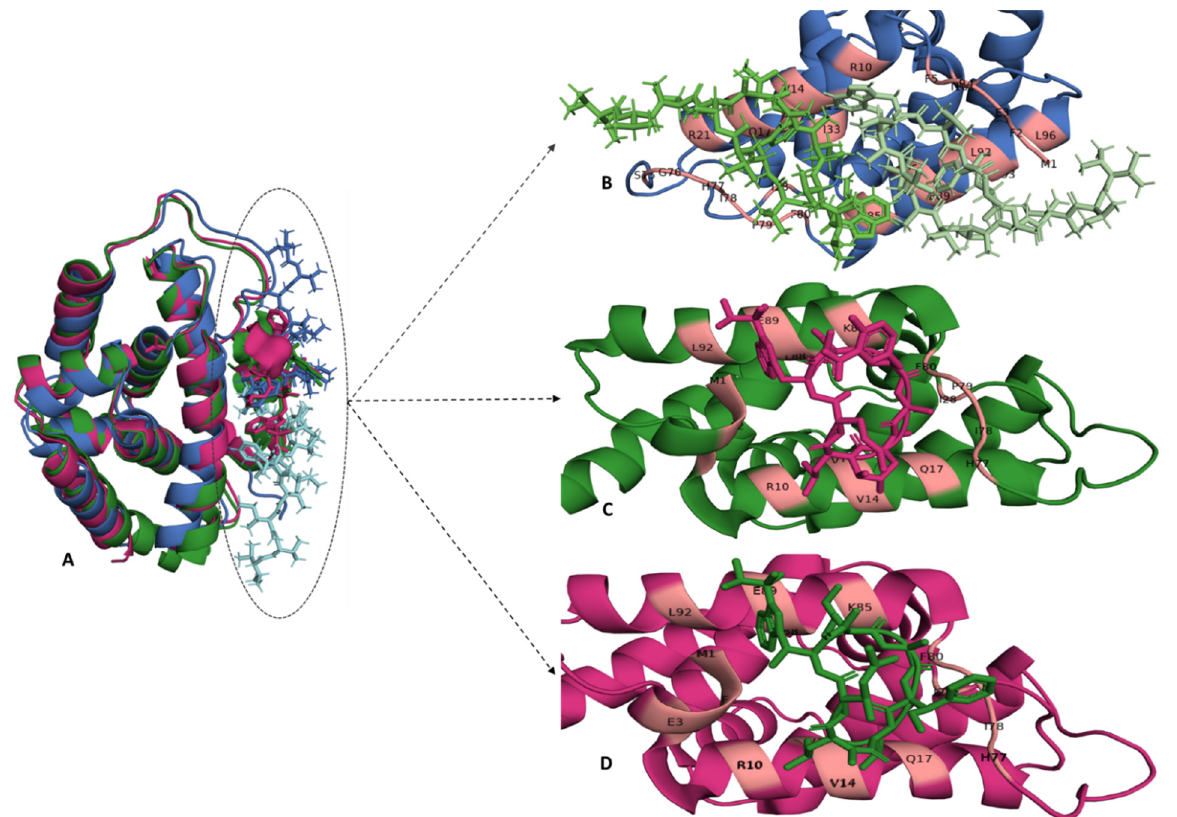
Figure 5. The binding site of Ecumicin, Cyclomarin-A and Rufomycin in the ClpC1 N-terminal domain. ( A ) The crystal structure of ClpC1-NTD-Ecumicin (PDB-6pbs), ClpC1-NTD-Rufomycin (PDB- 6cn8) and ClpC1-NTD-Cyclomarin A (PDB-3wdc) are shown in blue, green and pink, respectively, and were superimposed to compare the local environment of the three ligands. ( B ) The binding of two ecumicin molecules (ecumicin 1-light green, ecumicin 2-dark green) per ClpC1 N-terminal domain shows that these molecules bind adjacent to each other. The binding stochiometric ratio of rufomycin (pink) or cyclomarin A (green) to ClpC1 N-terminal domain is 1:1, represented in ( C ) and ( D ), respectively. The binding sites for these anti-TB peptides are predominantly located on residues in α -helices 1 and 5 and the loop region connecting α -helices 4 and 5. The interacting residues are coloured light pink on their respective secondary structural elements. The structures and interactions were visualised using PyMol